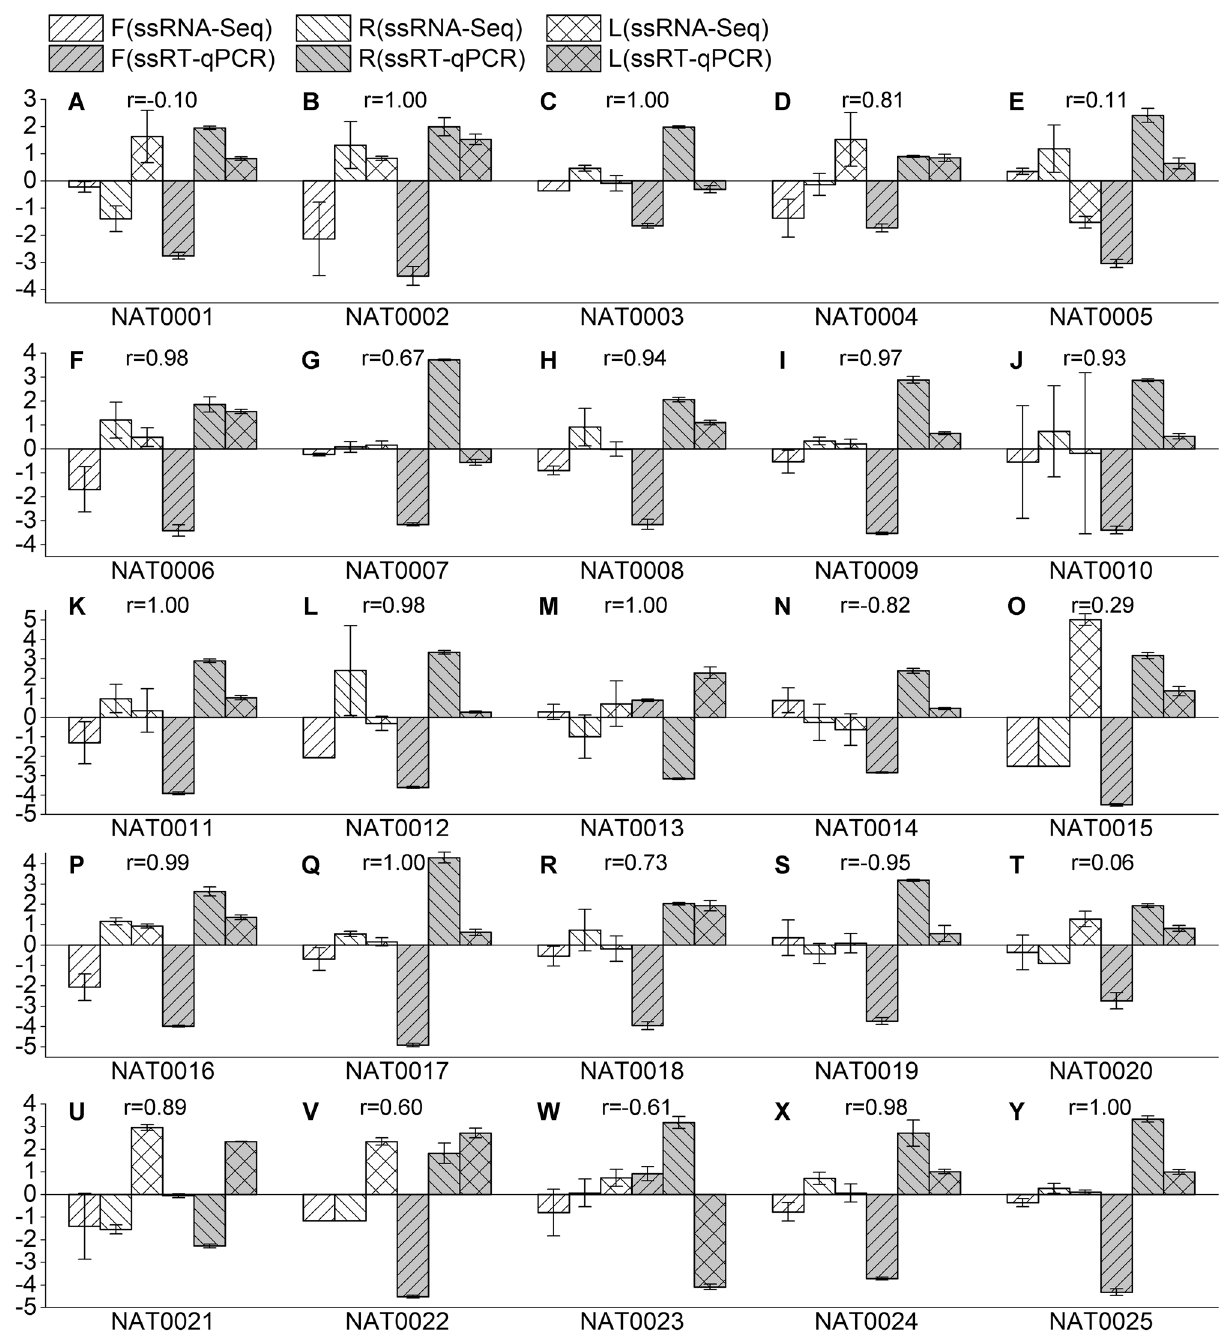
Figure 3. Validation of the expression level of 25 NATs in flower (F), root (R), and leaf (L) tissues of S. miltiorrhiza . The X-axis shows the expression levels in the three tissues using the two methods: ssRNA-seq and ssRT-qPCR. Y-axis shows the relative expression levels normalized to the mean expression levels across the three tissues. Error bars represent the standard errors. r: the correlation coefficient between the expression levels determined by the two